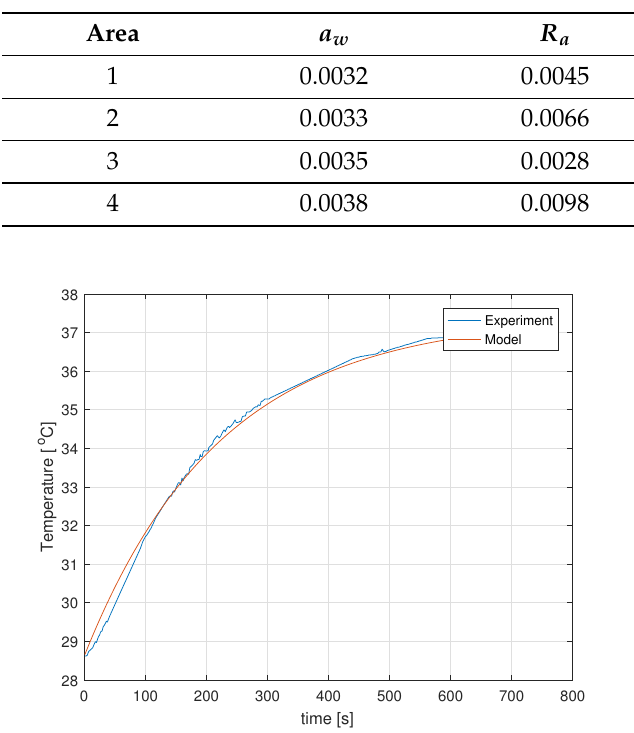
Figure 8. The step responses of the FO model and real plant for area 4. Next, the accuracy of the proposed FO model was compared to accuracy of analogical Integer Order (IO) model, obtained for α = 1.0. The step response of IO model was computed using MATLAB function step . Results are given in the Table 3 and illustrated by Figures 9–12. Table 3. Identified parameters of the integer order model.